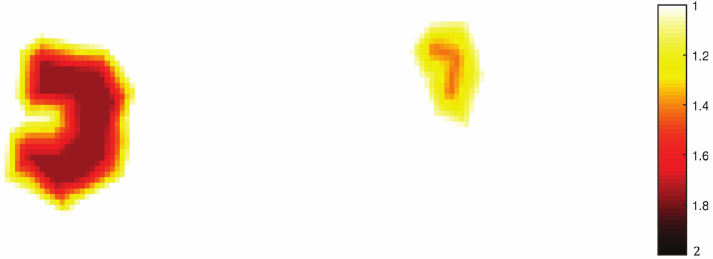
Figure 4. Spatial distribution of shoaling coefficient obtained with scheme FDM-flux.